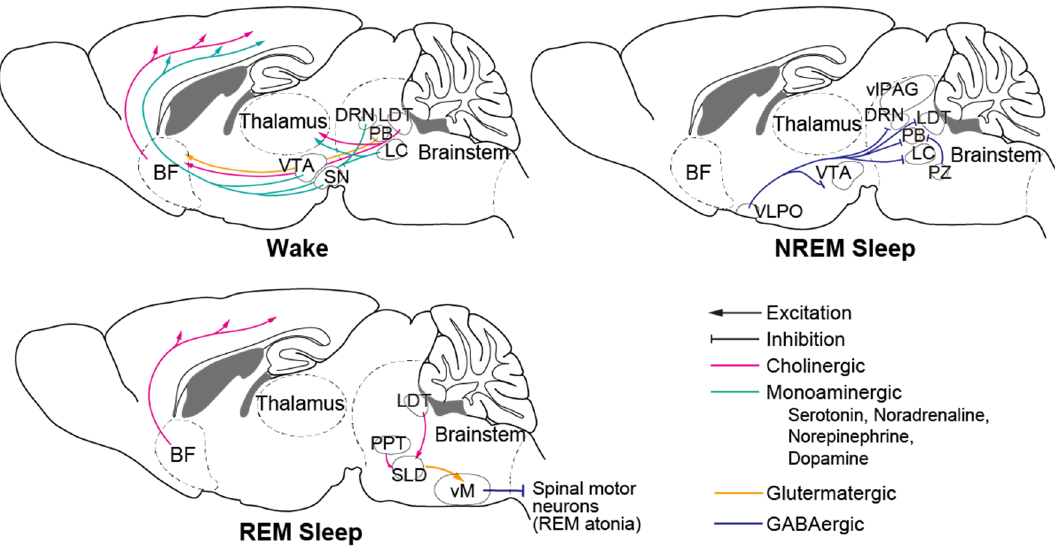
Figure 2. Principal neural circuit across wake and sleep. Monoaminergic neurons of wake-promoting nuclei in the brain stem innervate to thalamus and entire forebrain and activate during wake. During NREM sleep, NREM-active regions including PZ and VLPO inhibit those wake-promoting neurons. During REM sleep, SLD neurons activate vM neurons and inhibit spinal motor neurons that cause REM atonia. BF: basal forebrain; VTA: ventral tegmental area; SN: substantia nigra; DRN: dorsal raphe nucleus; LDT: laterodorsal tegmentum; PB: parabrachial nucleus; LC: locus coeruleus; vlPAG: ventrolateral periaqueductal grey; PZ: parafacial zone; VLPO: ventrolateral preoptic area; PPT: pedunculopontine tegmentum; SLD: sublateral dorsal nucleus; vM: ventral medulla.